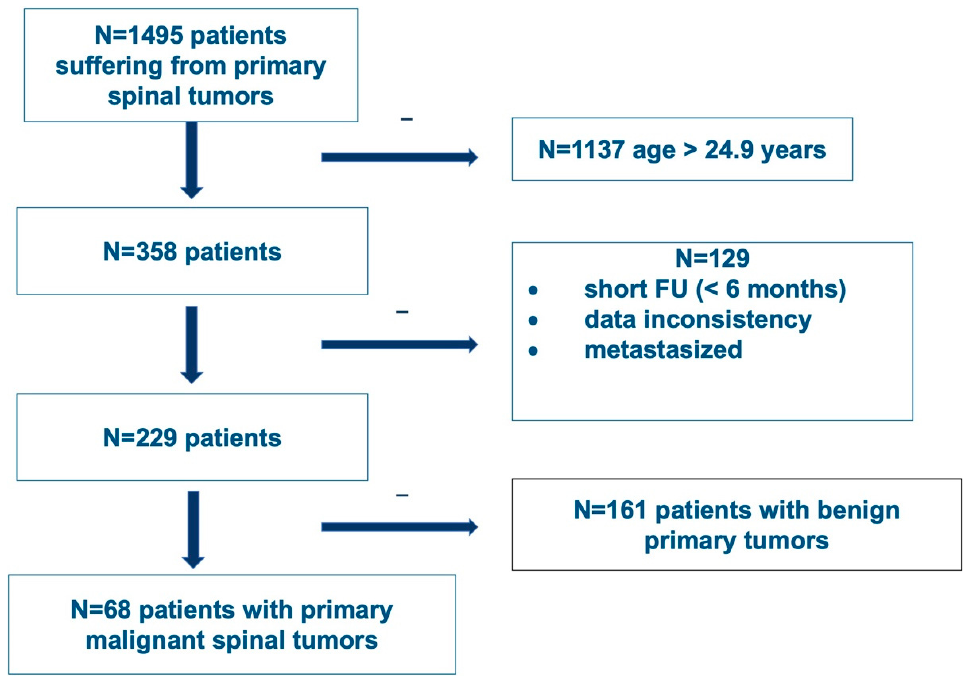
Figure 1. Flowchart of patient inclusion from the AO Spine Knowledge Forum Tumor’s Predictors of Mortality and Morbidity in the Surgical Management of Primary Tumors of the Spine study (Cin- icalTrials.gov Identifier NCT01643174). (CinicalTrials.gov Identifier